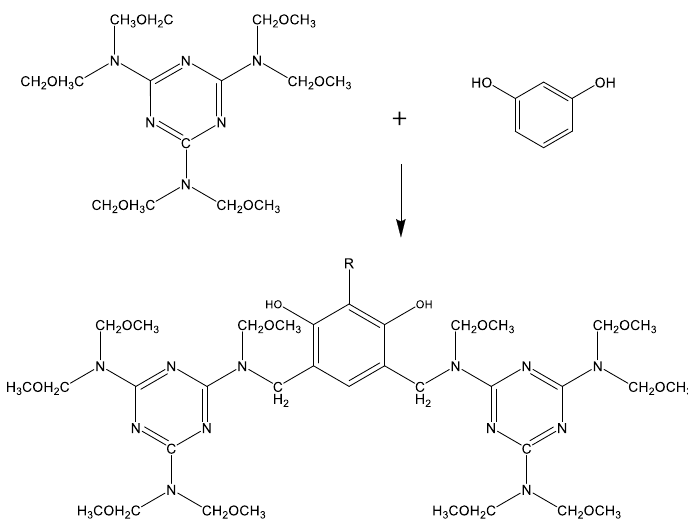
Figure 3. Formation process of active intermediates.